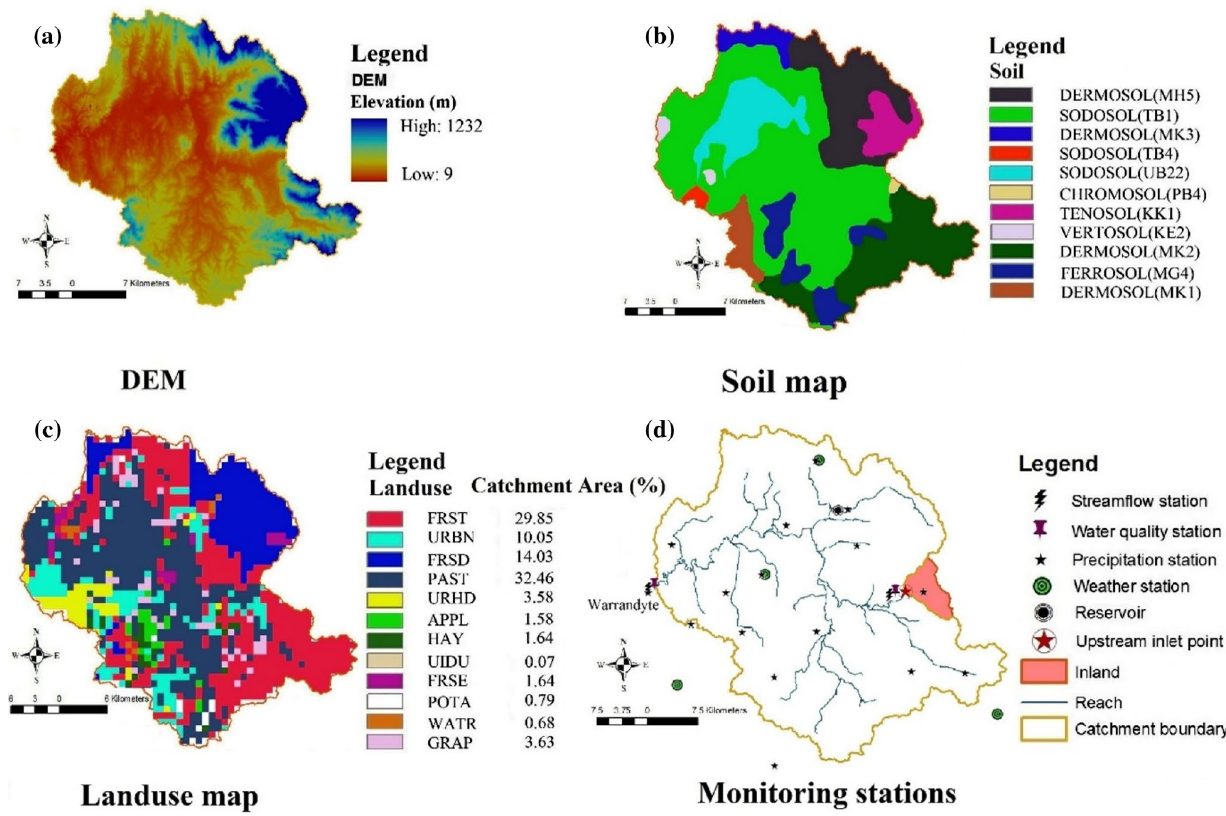
Fig. 2 Soil properties, land use, digital elevation and monitoring stations map for the SWAT model at the